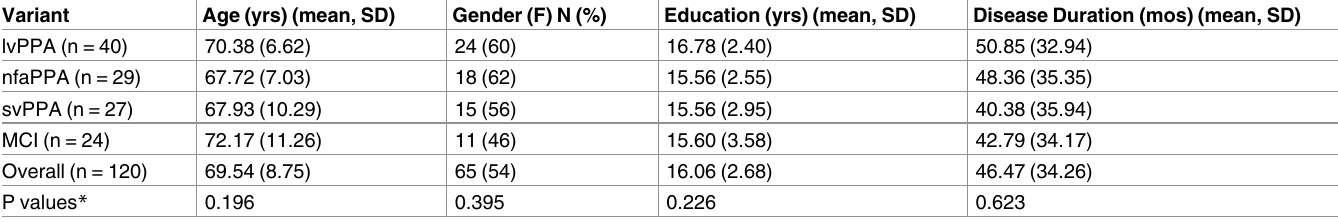
Table 1. Age, gender, education, and disease duration for PPA subtypes, MCI, and for participants overall. Variant